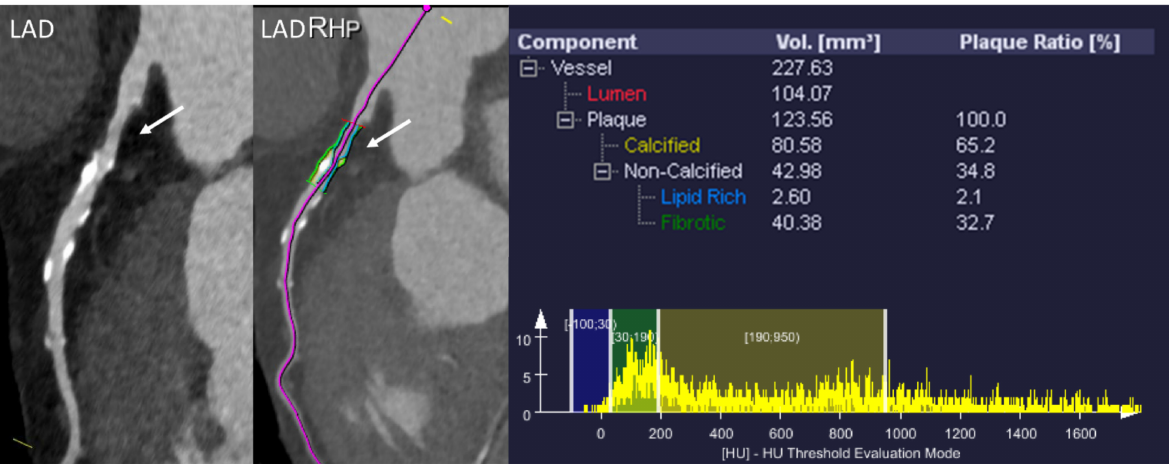
Figure 7. Example of plaque analysis (research software: syngo.via Frontier Coronary Plaque Analysis, Siemens Healthi- neers). Analysis performed in a moderate plaque in the proximal segment of the LAD. Note the presence of a partially calcified plaque with a predominance of calcium and a low percentage of